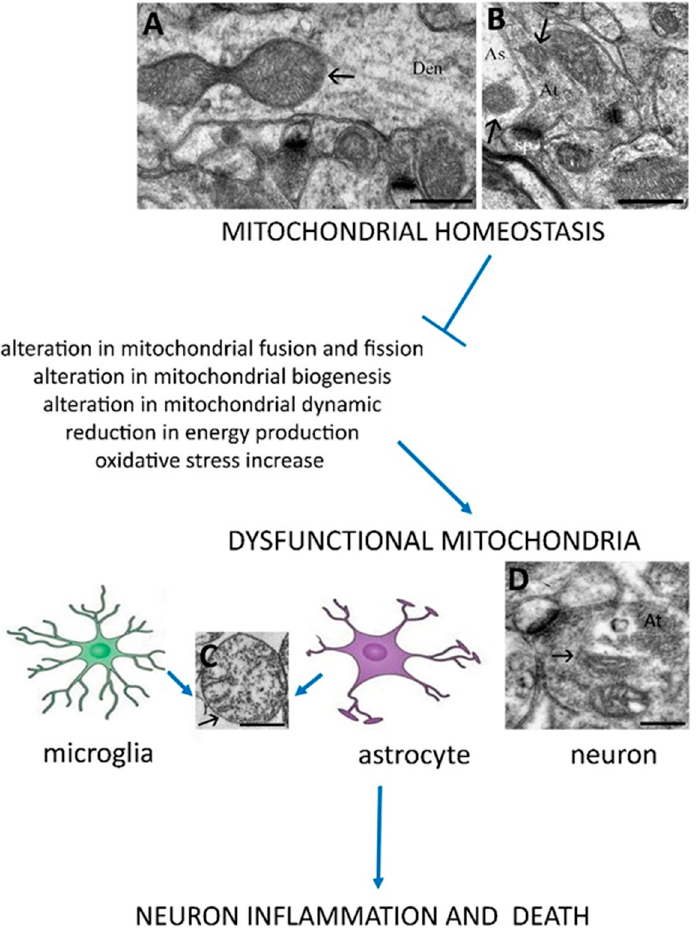
Figure 2. The scheme suggests that preserved mitochondrial processes such as correct biogenesis, fission and fusion, dynamics and other processes are necessary to reach neuron homeostasis. On the other hand, their deregulation in glial cells or neurons contributes to neuroninflammation and death. TEM images, obtained from an adult rat’s cerebral cortex, show mitochondria (arrows) in a dendritic cell (Den) during a fusion event ( A ), in an axon terminal (At) and in an astrocyte process (As) which surrounds a synapse ( B ). Altered mitochondria (black arrows) appear in ( C , D ). Bars: 500 nm for ( A – C ); 200 nm for ( D ). sp: dendritic spine.